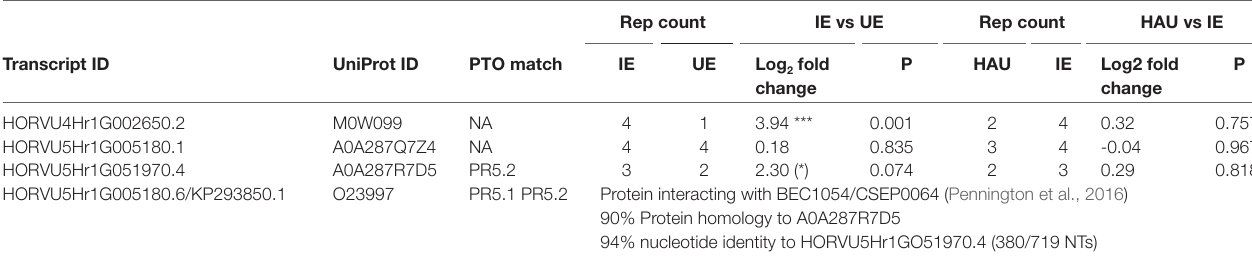
TABLE 3 | Thaumatin-like proteins with differential relative abundance in the IE vs UE